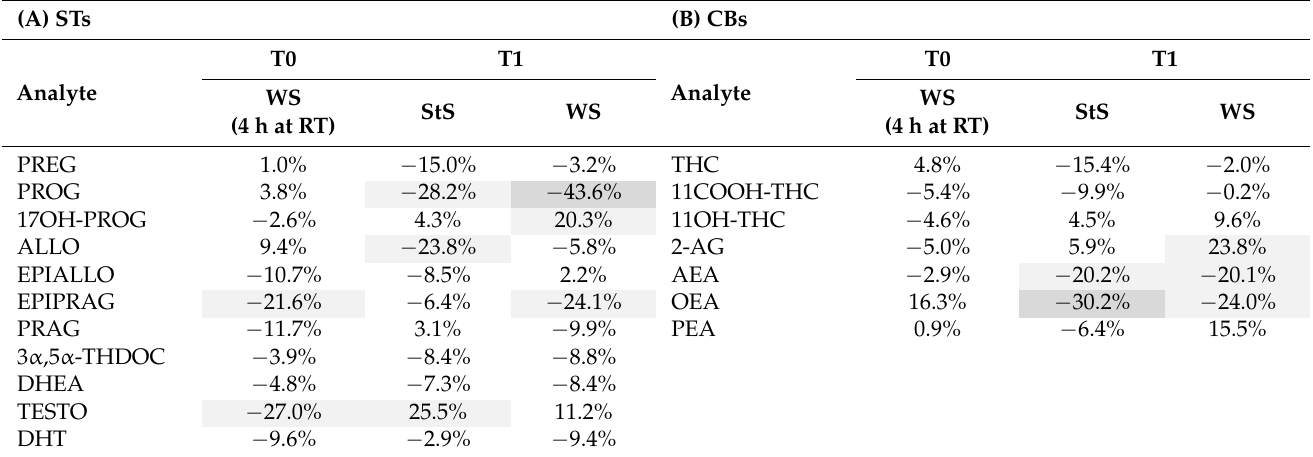
Table 9. Solution stability for steroids (STs) ( A ) and cannabinoids (CBs) ( B ) expressed as mean% difference (n = 3) from a fresh